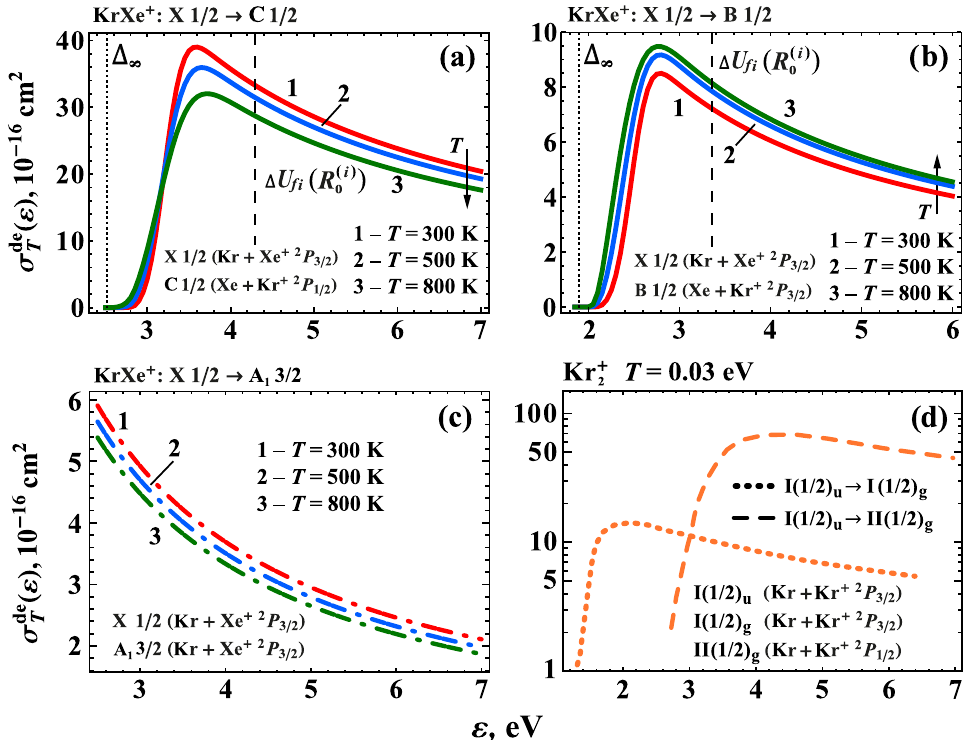
Figure 4. ( a , b ) Same as in Figure 3a,b for KrXe + . ( c ) Cross sections of dissociative excitation, σ de , of KrXe + ions via KrXe + ( X 1/2 ) + e → KrXe + ( A 1 3/2 ) + e → Kr + Xe + ( 2 P 3/2 ) + e to first T excited state A 1 3/2 transitions at T = 300, 500, 800 K. ( d ) σ de for homonuclear ions Kr + and T 2 ( I 1/2 u ) + e → Kr + ( I 1/2 g ) + e → Kr + Kr + ( 2 P ) + e (dotted lines) and Kr + ( I 1/2 u ) + e → Kr + 3/2 2 2 2 ) + e (dashed lines) transitions at gas temperatures T = 0.03 ( II 1/2 g ) + e → Kr + Kr + ( 2 P Kr + 1/2 2